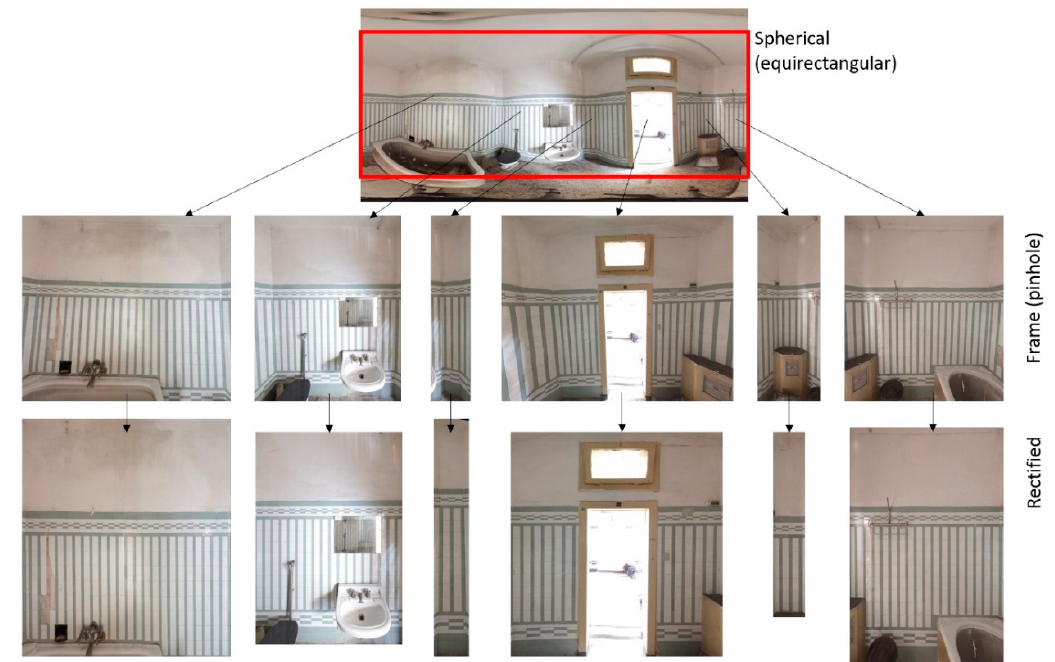
Figure 4. The rectification process of the different vertical walls using a single equirectangular projection, which replaces several frame images.